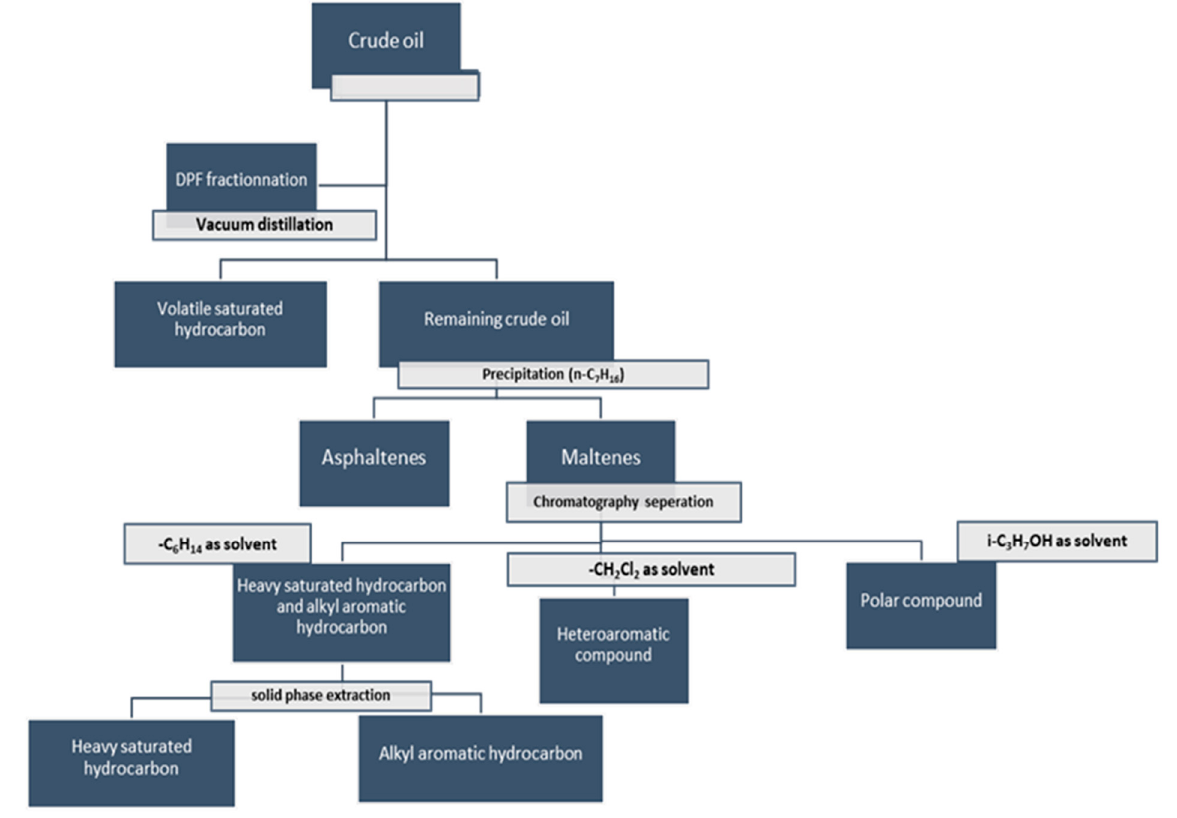
Figure 5. DPF fractionation steps [98].